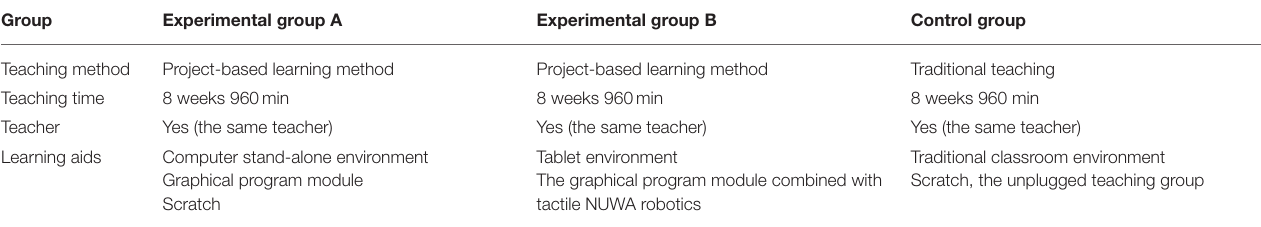
TABLE 2 | Scenario and teaching approach of three groups.